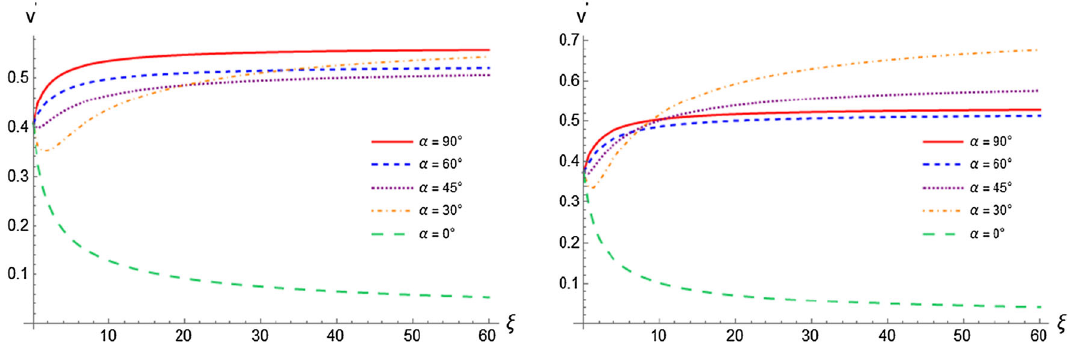
Fig. 6 Plots of the absolute value of downstream velocity | v (cid:2) (ξ | α) | as a function of the anisotropy parameter ξ for α = π/ 2 (solid), α = 2 π/ 3 (dashed), α = π/ 4 (dotted), α = π/ 6 (dashed-dotted) and α = 0 (long dash) for σ = 5 (left) and σ = 10 (right)